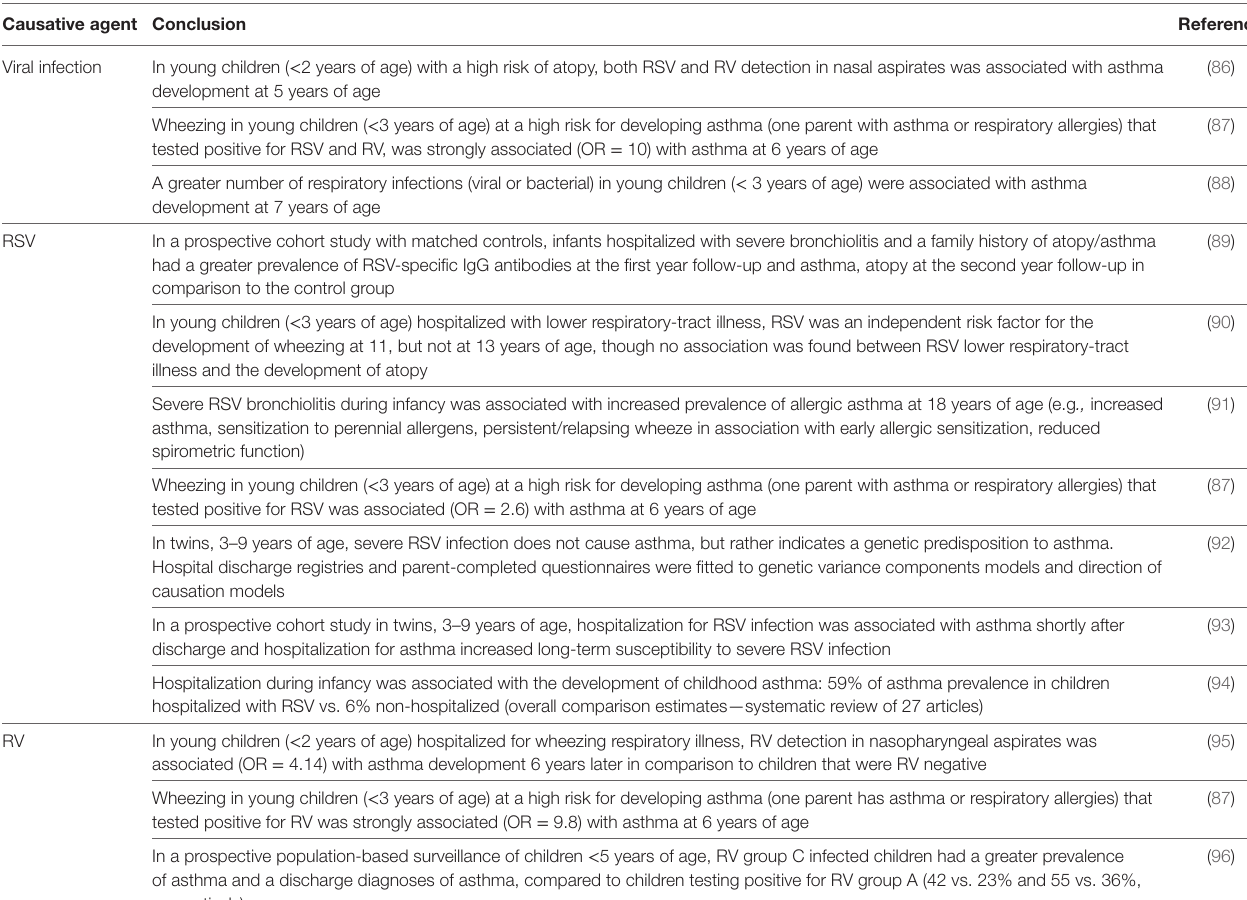
TABLe 1 | Evidence linking respiratory viral infection in infancy and asthma development in